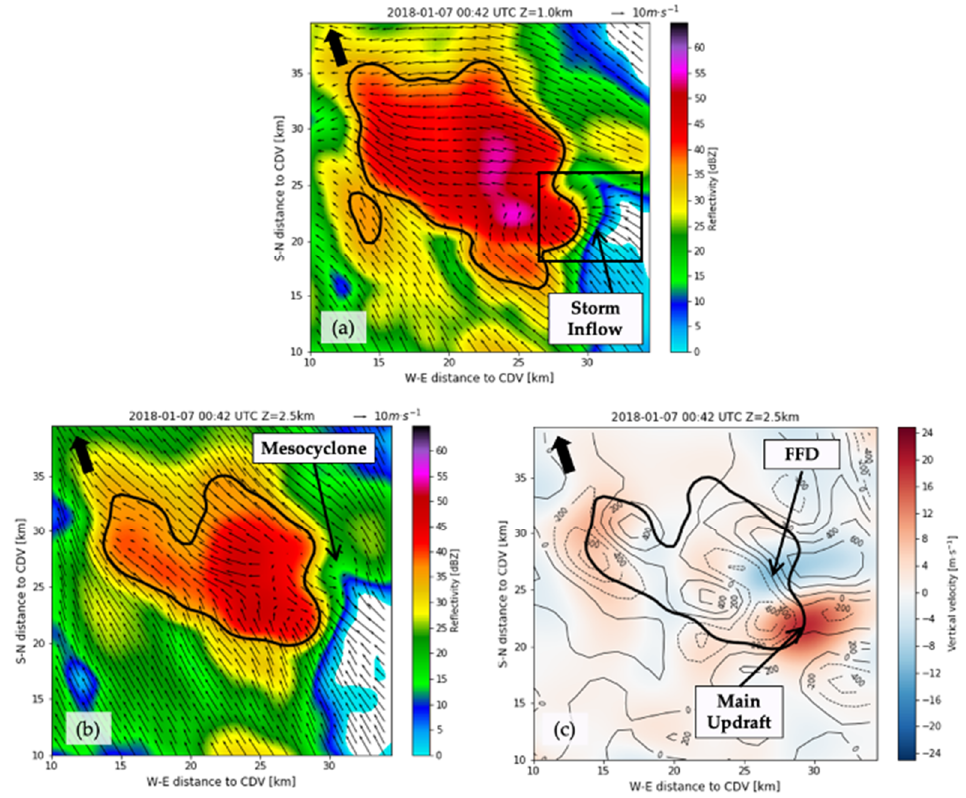
Figure 6. Retrieved SAMURAI fields for the supercell case on 7 January 2018 at 00:42 UTC. The thick black arrow in upper left indicates the steering flow at 3 km, and the black frame indicates the storm inflow. Reflectivity (dBZ) and storm-relative horizontal wind field (m · s − 1 ) with black arrows at ( a ) Z = 1.0 km and ( b ) Z = 2.5 km. ( c ) Vertical velocity in color scale ( w , in m · s − 1 ) and vertical vorticity ( ζ , in 10 − 5 · s − 1 ), represented with black contours (dashed and solid for negative and positive values, respectively). Contours are labeled every 200 × 10 − 5 · s − 1 (0 value not shown). The 35 dBZ contour is depicted with the thick black line.